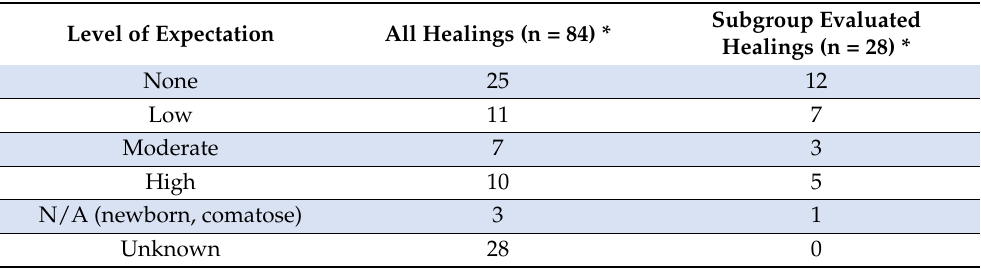
Table 12. level of expectation to be healed by prayer in retrospective self-report, for all healings (n = 84) and for those evaluated (n =